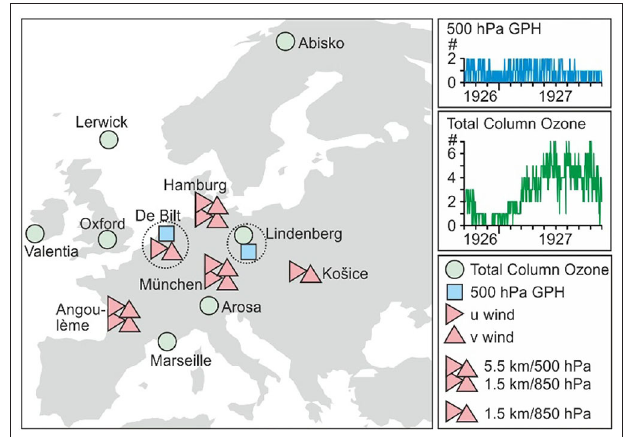
FIGURE 6 | Map with predictors used in the 1926/27 experiment. Time series indicate the number of observations assimilated per day.